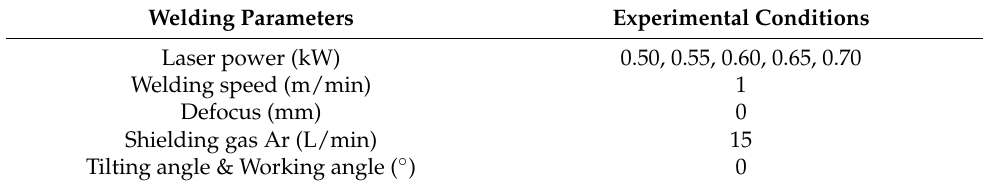
Table 3. 1st Conditions of laser welding for 0.25 mm thickness of ASTM F1684.